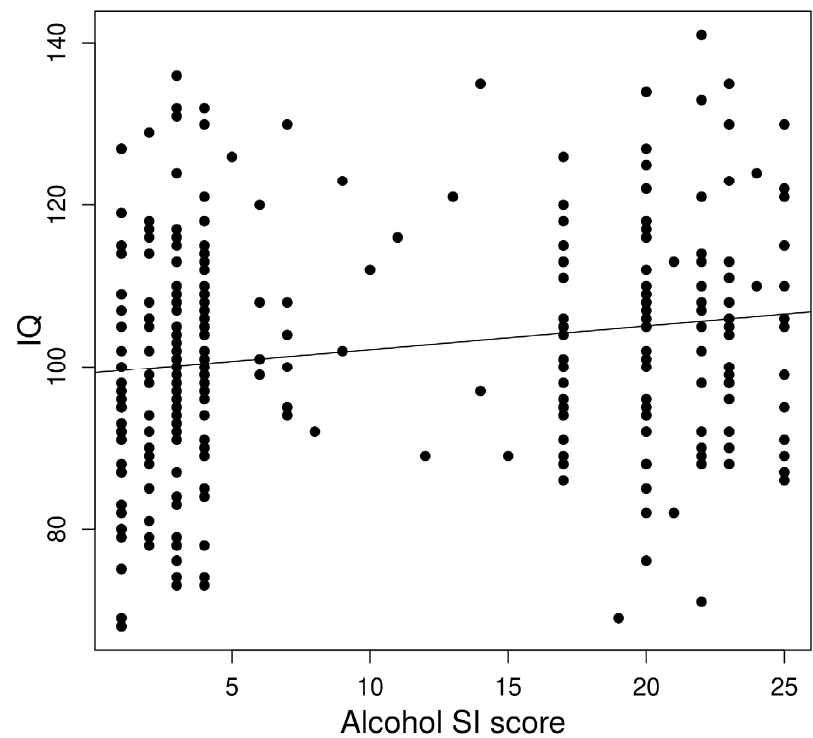
Figure 3. Association between alcohol dependence risk and IQ.